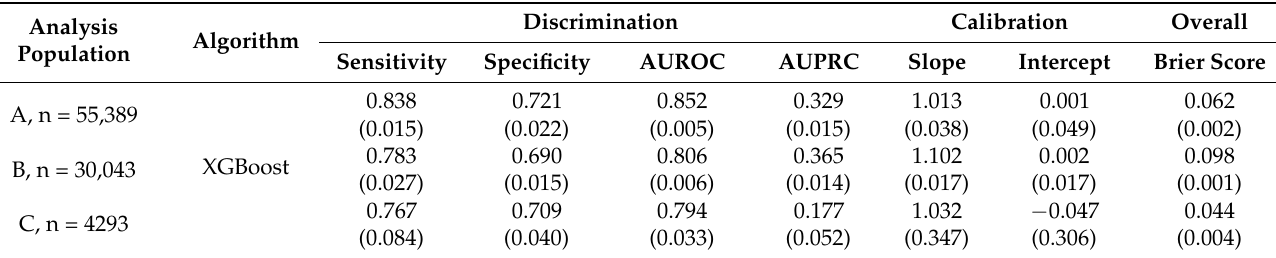
Table 2. Predictive performance of prediction